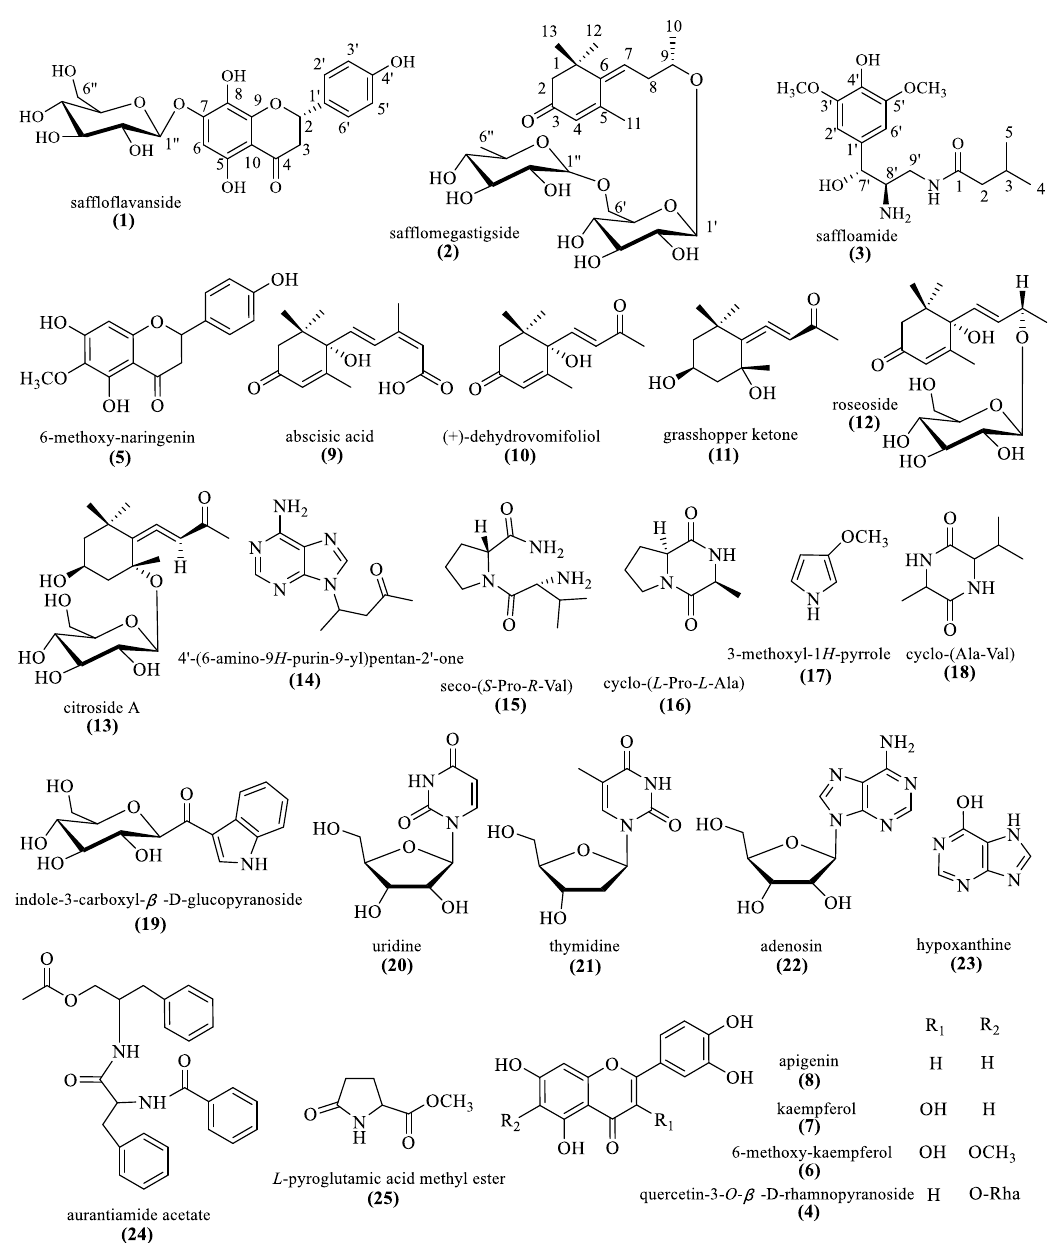
Figure 1. The chemical structures of compounds 1 – 25 . Compound 1 was isolated as a green, amorphous solid and had a [M+H] + ion peak at m / z 451.1260 in its HRESIMS, corresponding to the molecular formula C 21 H 23 O 11 . The 1 H NMR data (Table 1) of 1 displayed the presence of a 1,4-disubstituted aromatic ring [ δ H